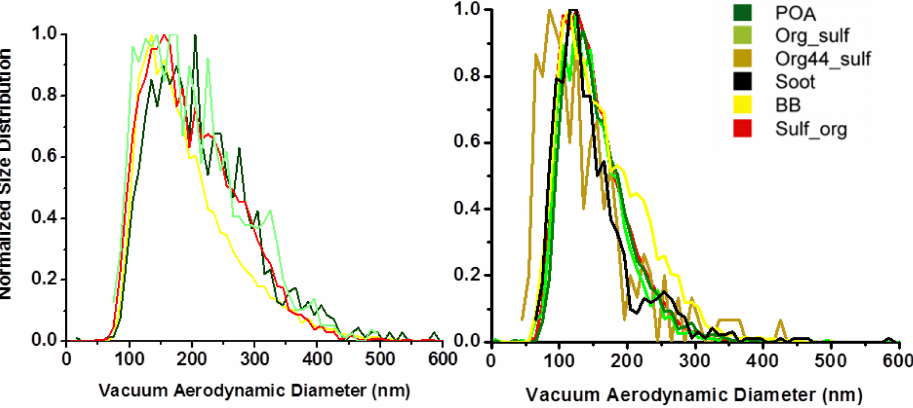
Fig. 7. Composition-resolved size distributions of aerosols sampled on 11 March (a) and 15 March (b) . Note the colors are the same in both plots. Only the particle types that contributed measurably to the overall composition are